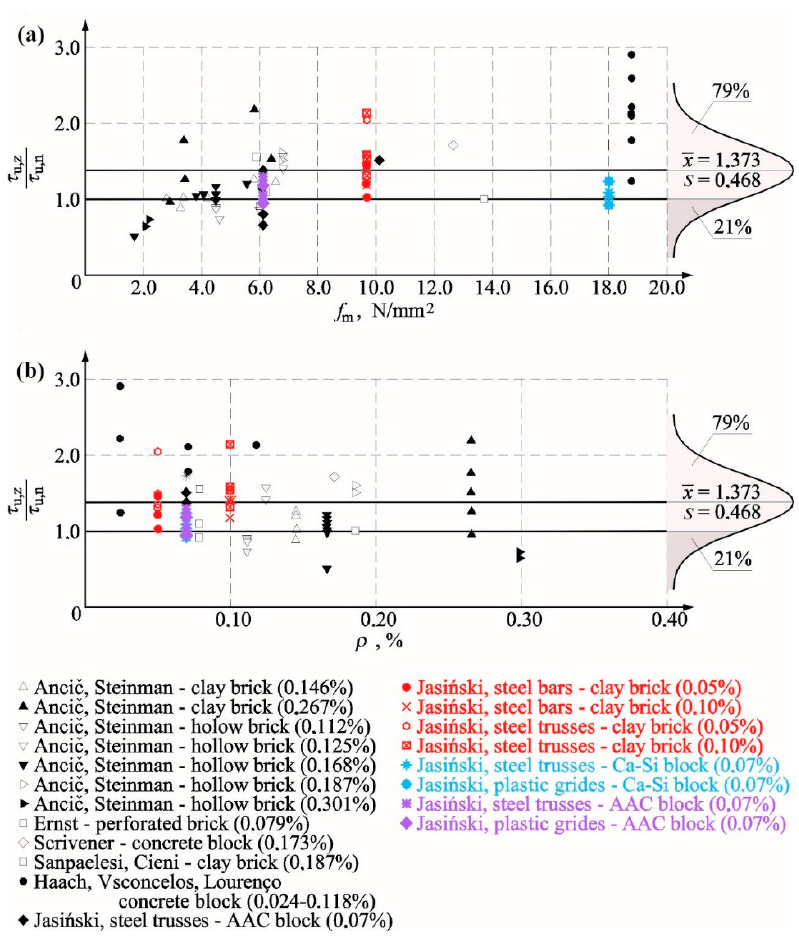
Figure 16. Summary of test results: (a) failure shear stress value for reinforced wall τ u,z /failure shear stress value for unreinforced wall τ u,n —depending on percentage of horizontal reinforcement ρ —and (b) ratio τ u,z / τ u,n — compressive strength of mortar f m .